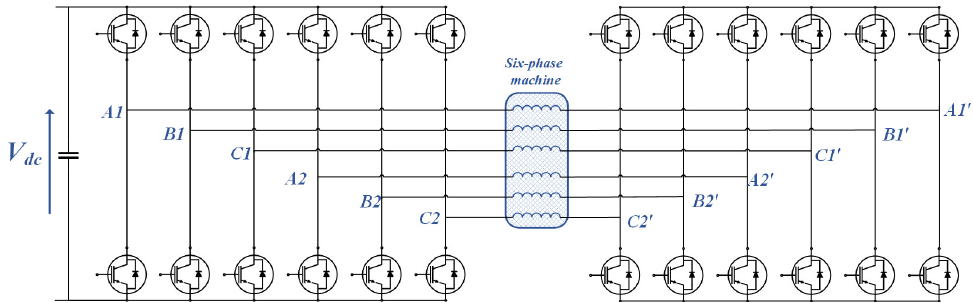
Figure 24. Open-end winding, six-phase topology with dual, two-level inverters and a single dc source (topology II).